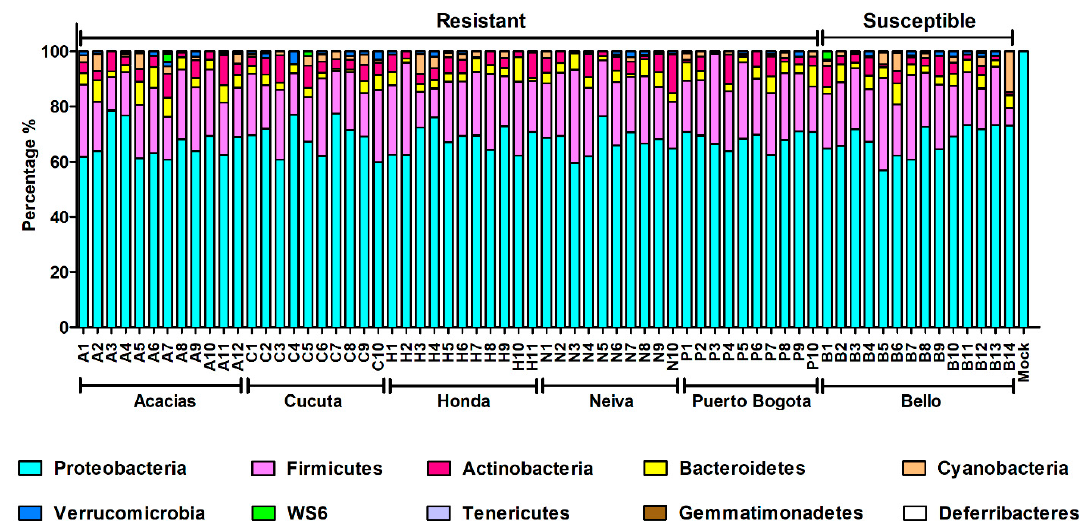
Figure 6. Comparison of the abundance of bacteria analyzed at the phylum level between lambda-cyhalothrin-resistant and -susceptible mosquitoes from six Colombian cities.